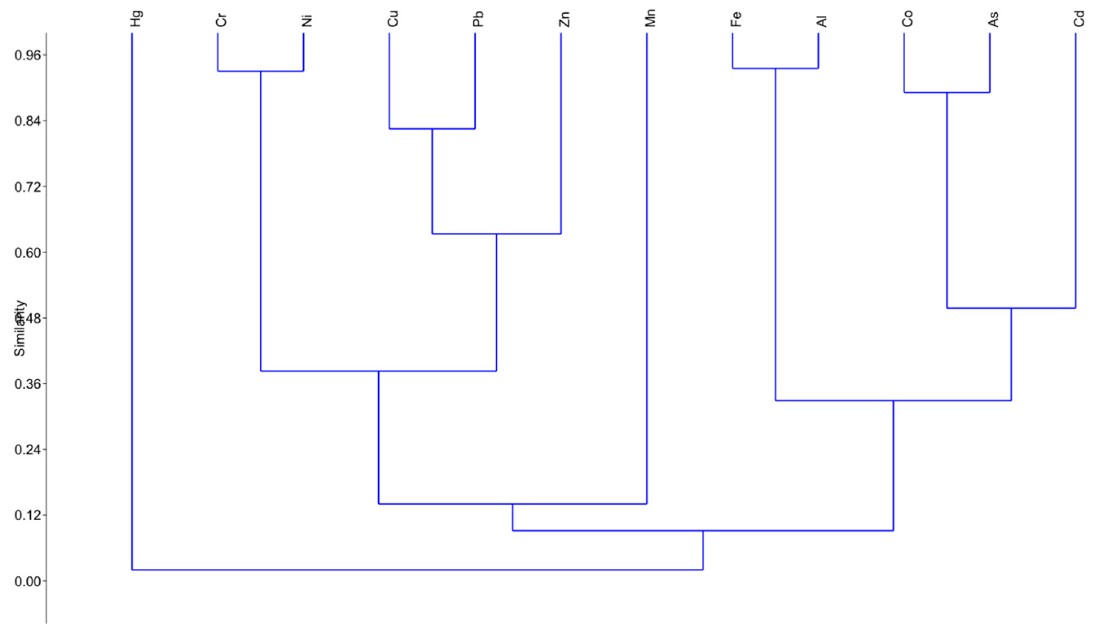
Figure 2. Cluster analysis: dendrogram of trace elements in Fontinalis antipyretica (unweighted pair-group average linkage, Bray–Curtis similarity index).